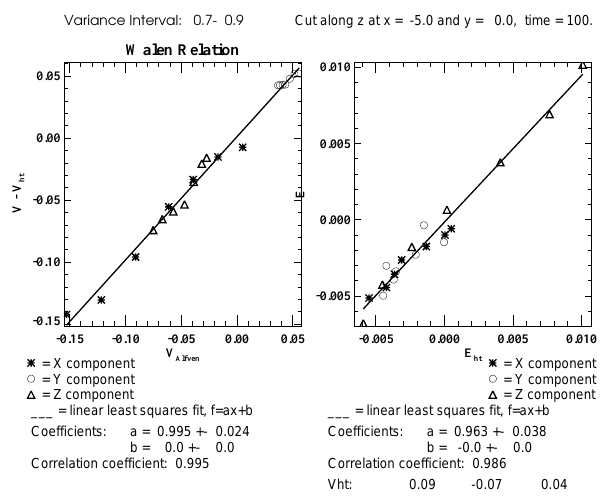
Fig. 6. Wal ´ en relation (left) and deHoffman-Teller test (right) re- sults for the CDC/magnetosheath boundary for the interval z = [ 0 . 7 − 0 . 9 ] at (x,y) = ( − 5 , 0 )